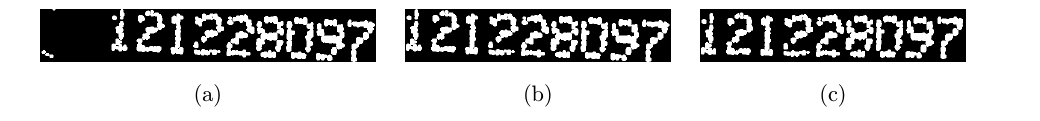
Fig. 8. Cut out DMDC image and its treatment. (a) Cut out DMDC image, (b) image after noise elimination, and (c) image after incline correction.